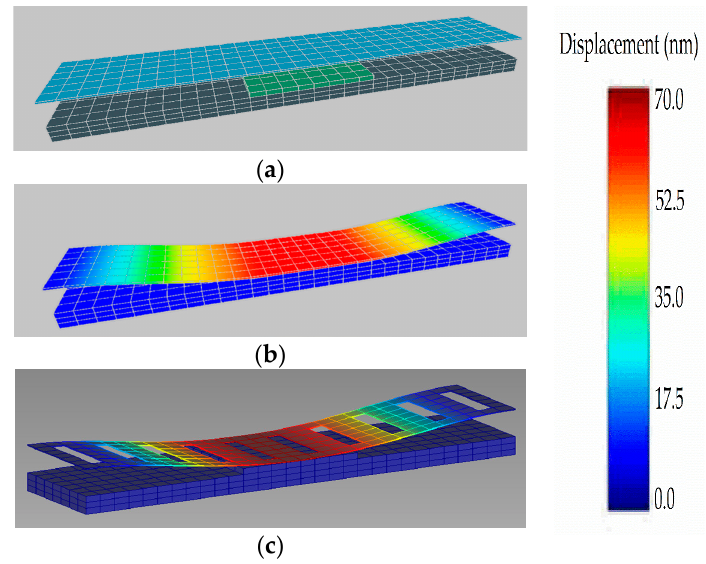
Figure 4. Graphene-based NEM switch with bottom actuation electrode during: ( a ) ‘off-state’ mode; ( b ) ‘on-state’ mode; ( c ) ‘on-state’ mode for the perforated graphene beam.